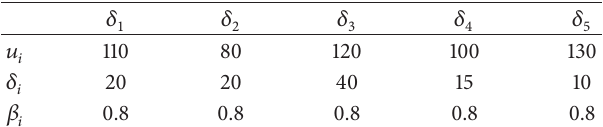
Table 7: The stochastic distribution of passenger generated